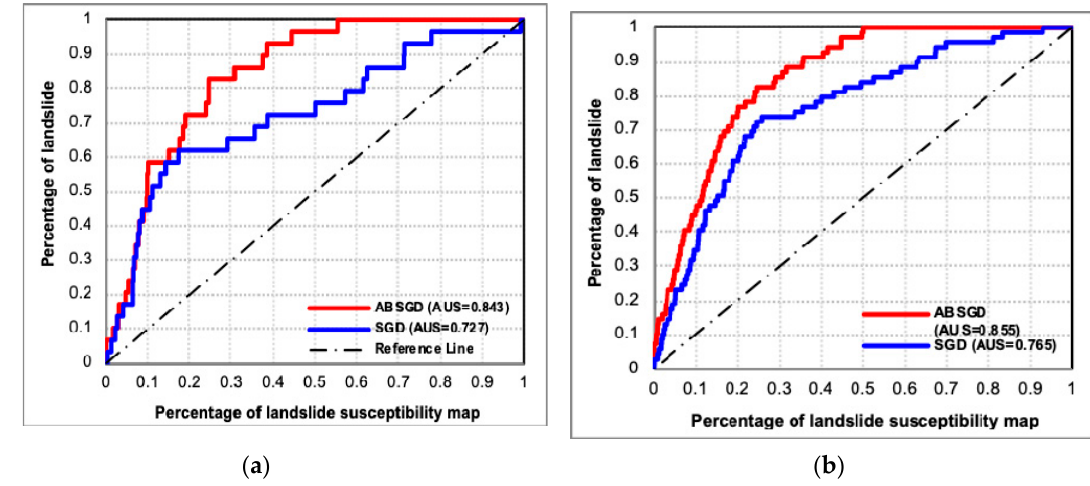
Figure 7. Landslide model validation and comparison using: ( a ) success rate curve and ( b ) prediction rate curve.